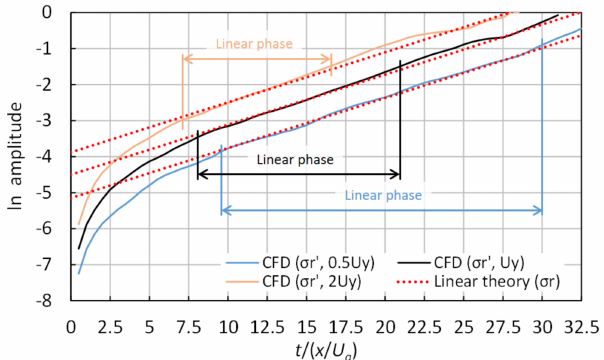
Figure 4. Time variation of the natural logarithm of the disturbance amplitude for different initial velocities in the Y direction of the perturbations, in the case of 3000 ( X direction) × 400 ( Y direction) cells, C α = 0, and We g =